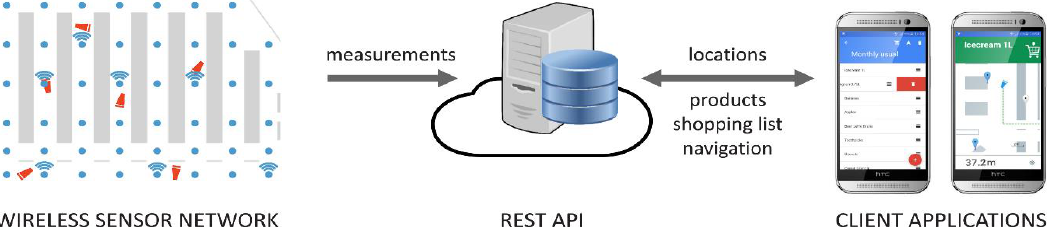
Figure 7. Navindo indoor navigation system. (1) Wireless sensor network with nodes deployed at fixed locations (i.e., above aisles in the supermarket) and simple IR transmitters (tags) on mobile objects that are being located—carts. (2) Application programming interface (API) that provides support for managing both the location data and the information about the target navigation area. (3) Client mobile applications used for accessing, managing, and visualizing location data.